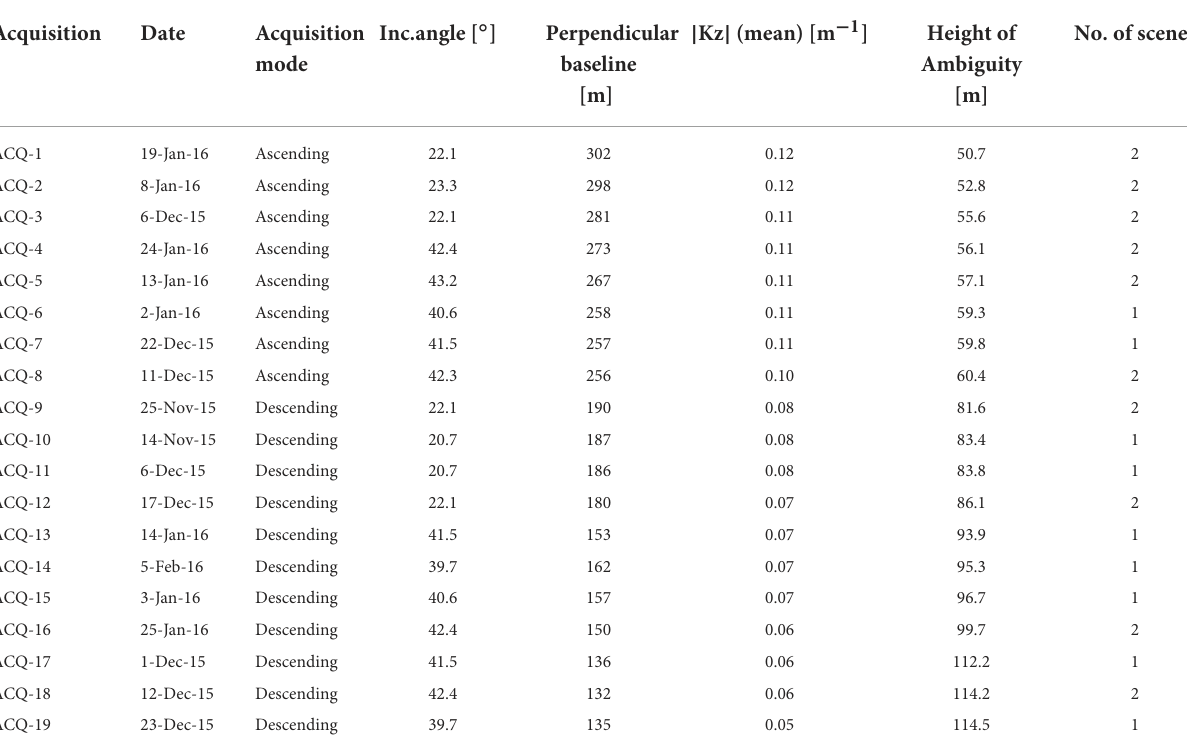
TABLE 1 Details of TanDEM-X acquisitions in increasing order of Height of